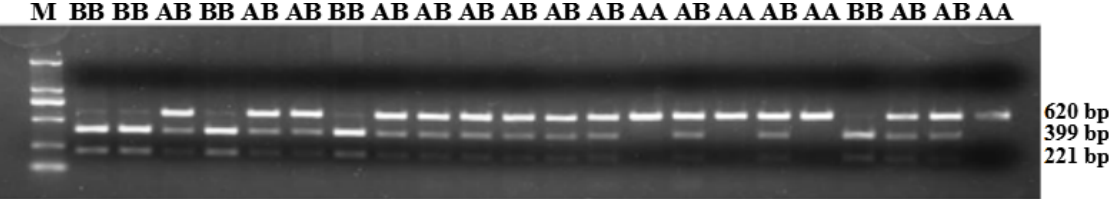
analysis was conducted, the g.-61bpG > T loci in the 5 (cid:48) - untranslated region (5 (cid:48) UTR) was selected to study the effect of ZNF33B polymorphism with superovulation